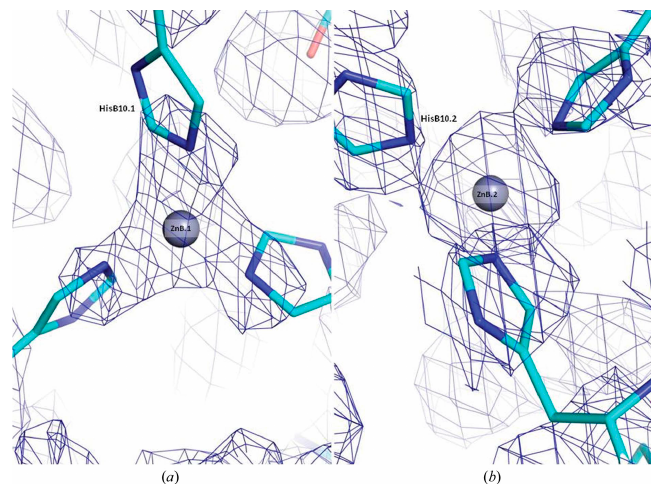
Figure 7. Selected regions of the total OMIT map contoured at 1 σ clearly indicating the positions and coordination of the two zinc ions present in T 6 bovine insulin. The map was computed using SFCHECK. The residues represented as cyan sticks correspond to the starting model, 2a3g, and the grey spheres represent the two independent zinc ions, ( a ) ZnB.1 and ( b ) ZnB.2, octahedrally coordinated by three symmetry-related HisB10 side chains. This figure was generated using PYMOL [12].